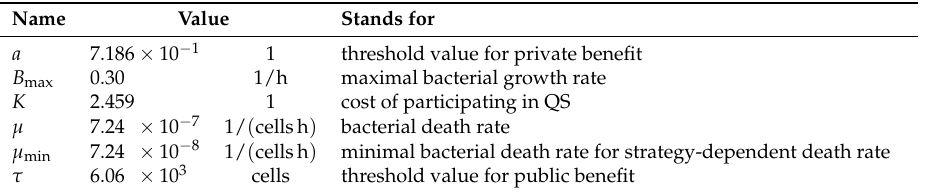
Table A1. Table of all occurring